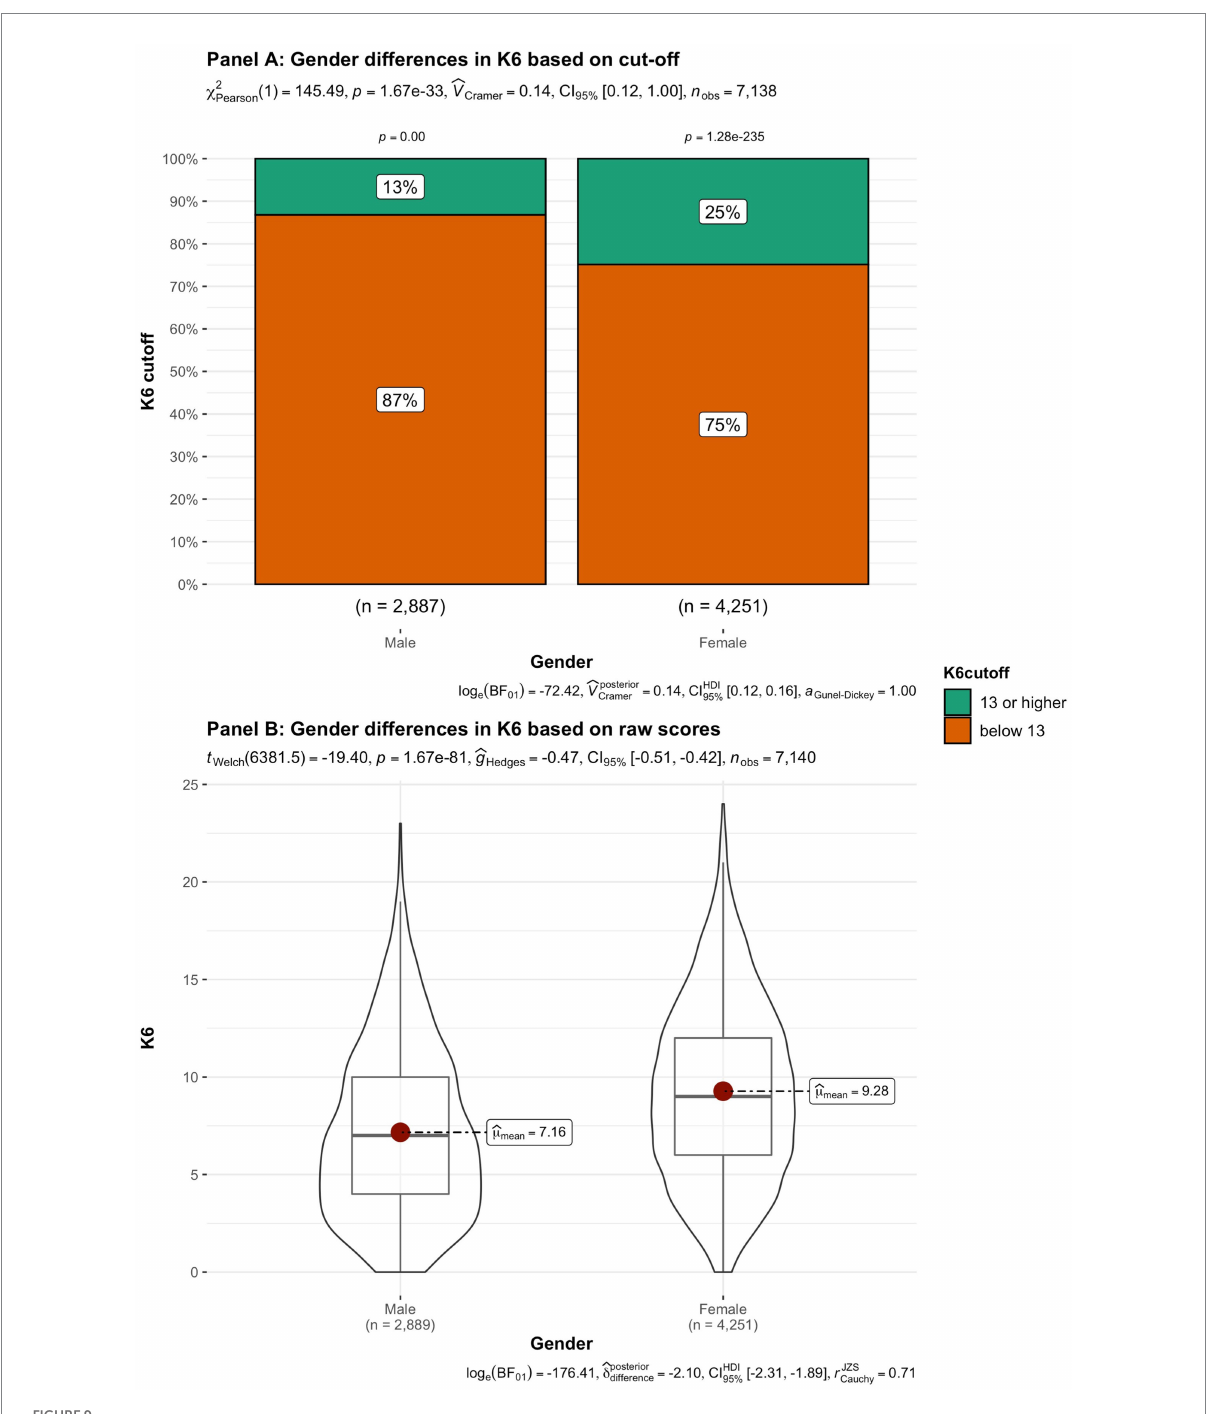
FIGURE 9 Summated scores on the K6 (indicator of mental illness and considered as a cutoff variable) across student subgroups in terms of